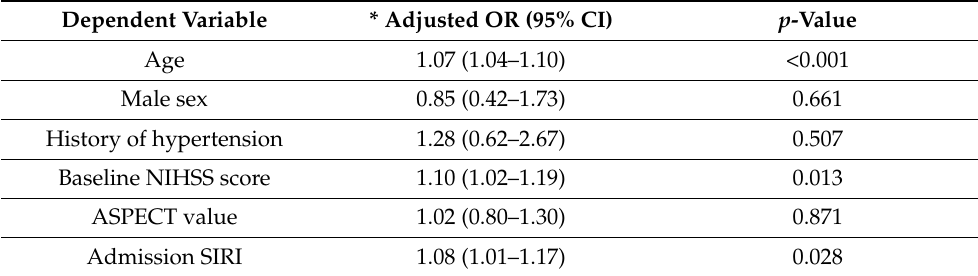
Table 2. Association between baseline characteristics and futile recanalization.